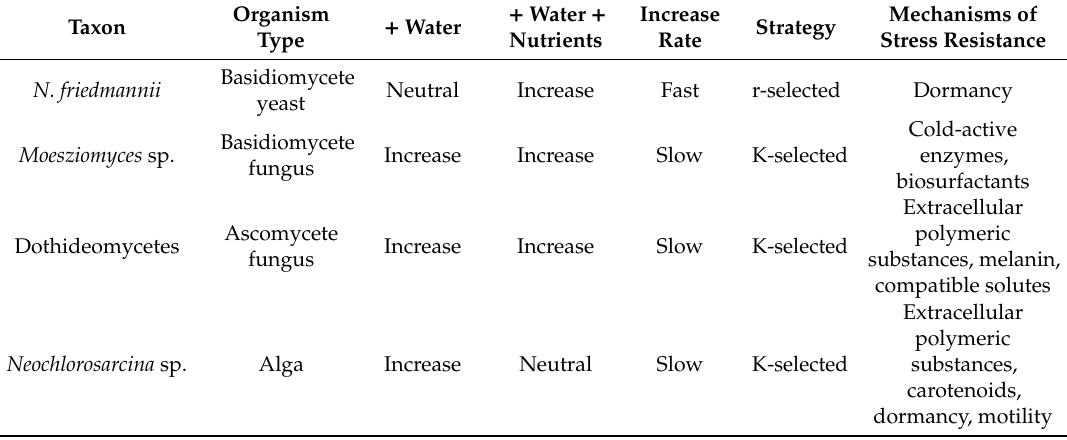
Table 3. Summary of key eukaryotic taxa, their responses to water and nutrient additions, their rate of response(fast = respondedafter first addition; slow = respondedafter multiple additions), their potential general evolutionary strategy and their mechanisms of stress resistance from the literature. + Water + Organism Increase Mechanisms of + Water Taxon Strategy Type Nutrients Rate Stress Resistance Basidiomycete N. friedmannii Neutral Increase Fast r-selected Dormancy yeast Cold-active Basidiomycete Moesziomyces sp. enzymes, Increase Increase Slow K-selected fungus biosurfactants Extracellular Ascomycete polymeric Dothideomycetes Increase Increase Slow K-selected fungus substances, melanin, compatible solutes Extracellular polymeric Neochlorosarcina sp. Alga Increase Neutral Slow K-selected substances, carotenoids, dormancy,